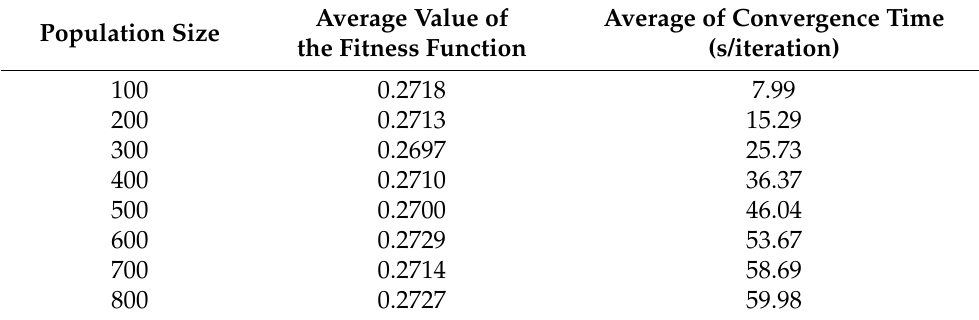
Table 6. The average convergence time under different population sizes.